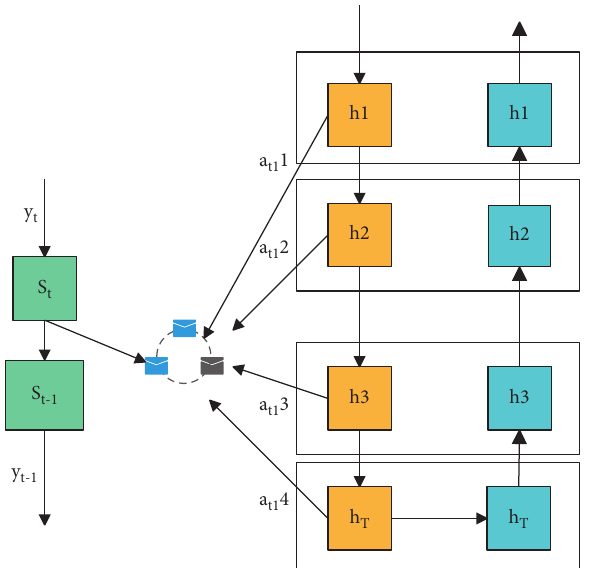
Figure 5: Schematic diagram of attention mechanism in Tacotron model